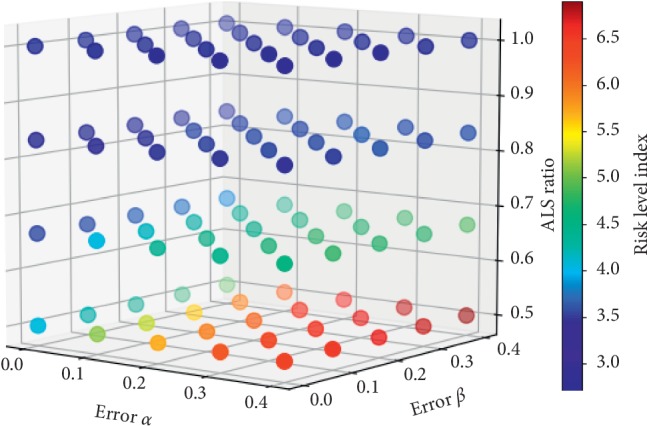
Risk level index plot for the ALS ratio, error α, and error β.